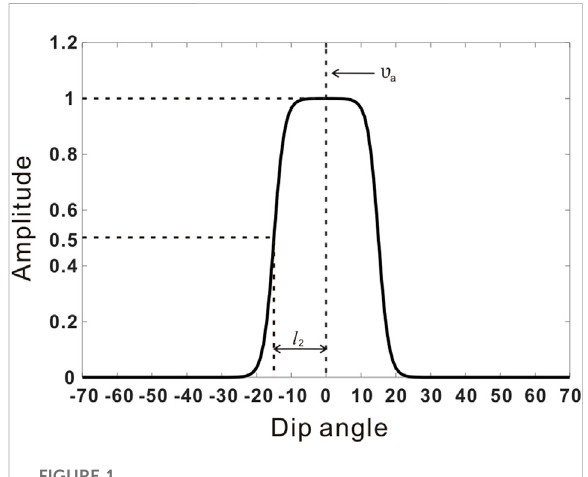
FIGURE 1 The schematic of the variant sigmoid weighting